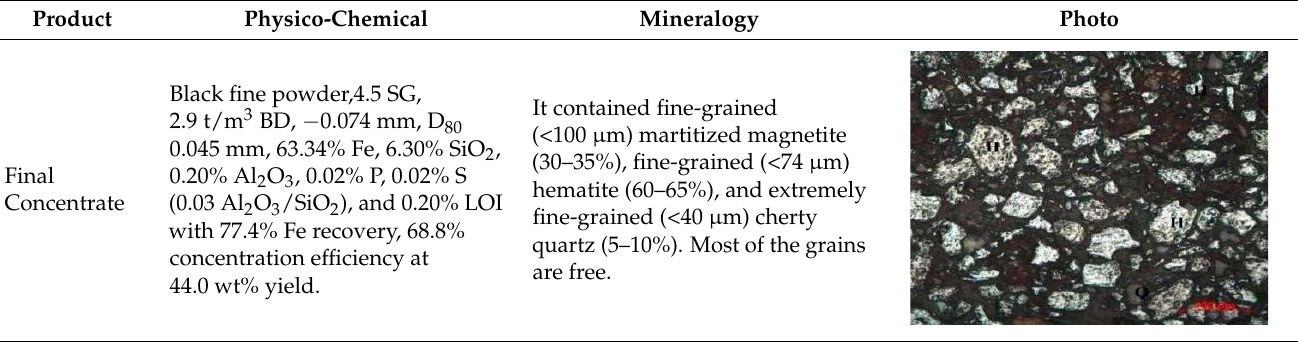
Table 12. The characteristics of tails of the final process.